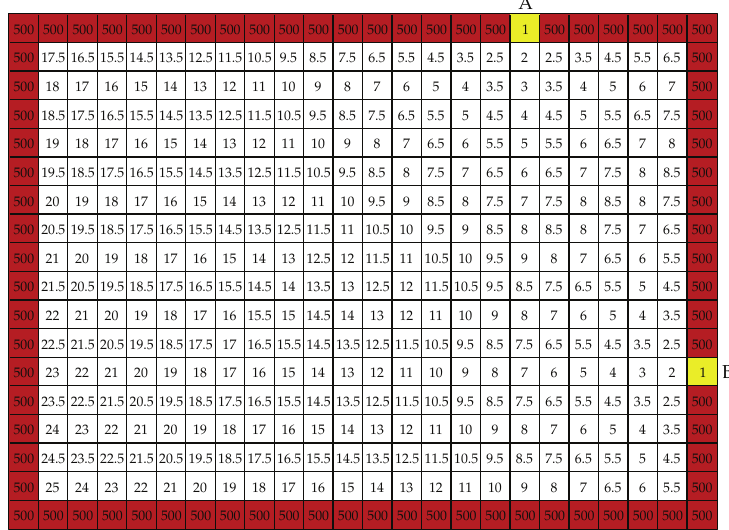
Figure 2: Values of the floor field in Figure 1 computed based on static field